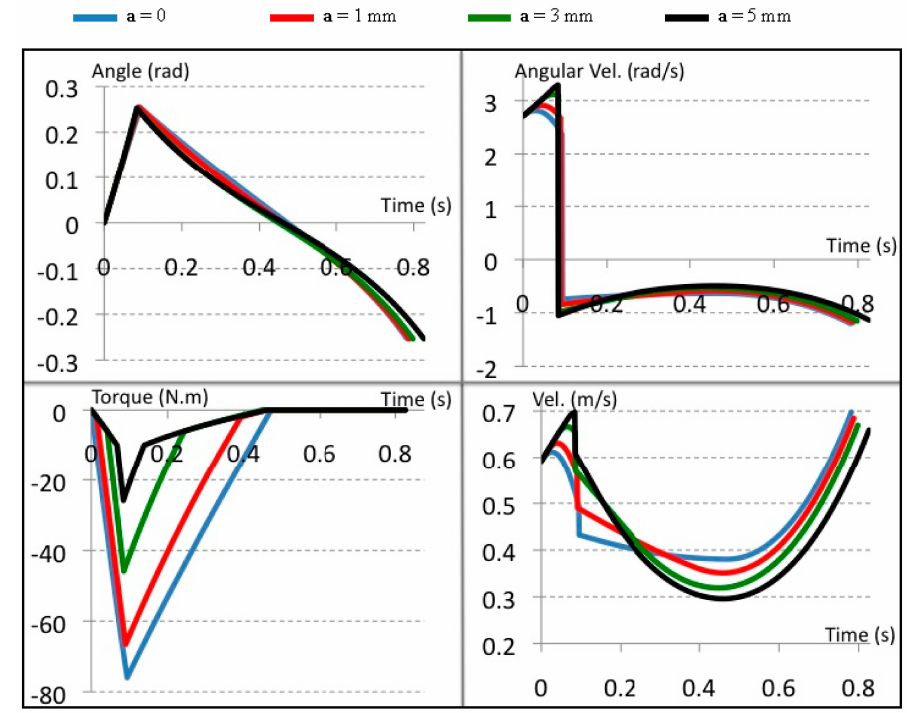
Figure 22. Simulation data for one-step walking in passive mode. The data is for 4 experimental tests with different offset positions. Low stiffness spring constant = 80 N/mm. High stiffness spring constant = 400 N/mm. ( a ) ankle pitch joint angle; ( b ) ankle pitch joint angular velocity; ( c ) ankle pitch joint torque; ( d ) CoM forward